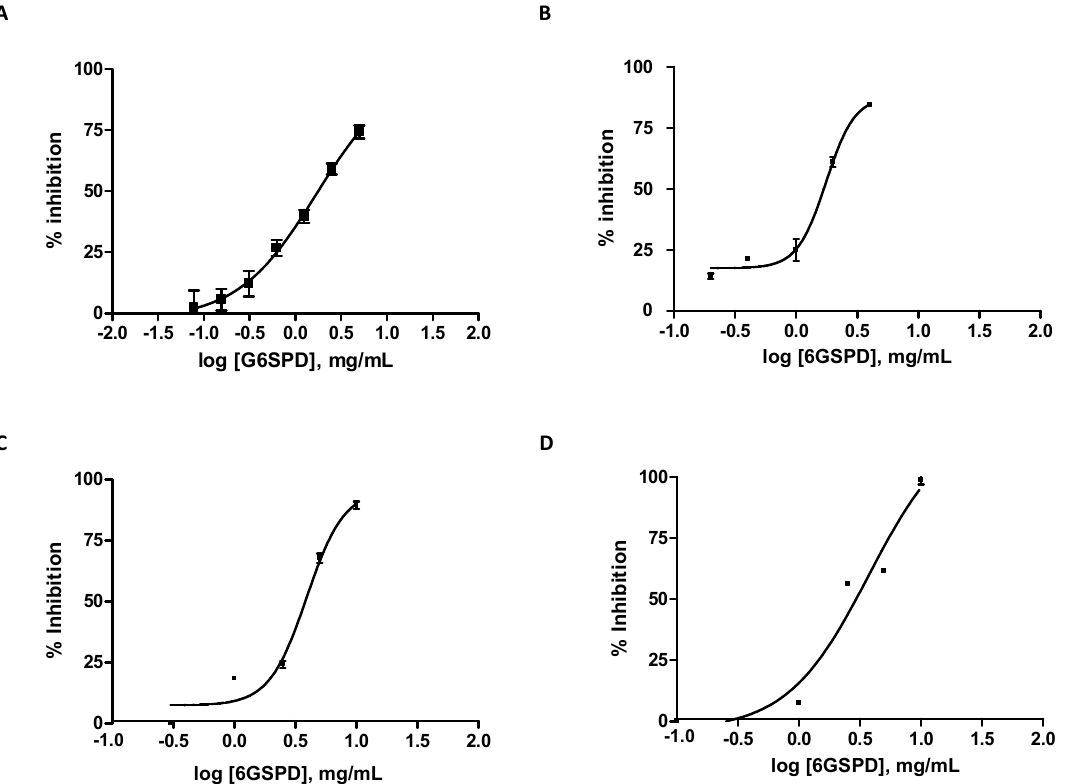
Figure 1. Germinated soybean protein digest inhibited DPP-IV ( A ), α-amylase ( B ) and maltase ( C ) and sucrase ( D ) activities of intestinal α-glucosidases Values are the mean ± standard deviation of three experiments performed in triplicate. Table 1. Inhibitory activity (expressed as IC 50 or peptide concentration needed to inhibit by 50% the original enzyme activity) of six days germinated soybean protein digest (6GSPD) and peptide fractions obtained by ultrafiltration against dipeptidyl peptidase-IV (DPP-IV), α-amylase, and α-glucosidases.